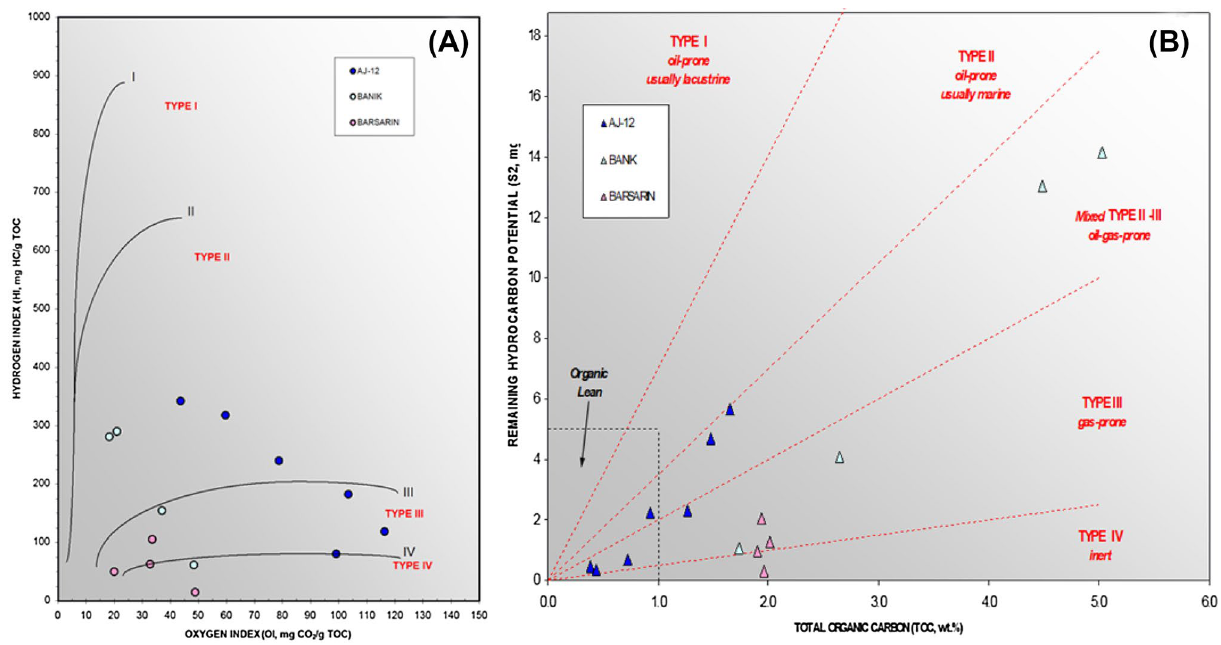
Fig. 12 a Cross plot of HI vs. OI of Chia Gara Formation, b Plot of Total Organic Carbon (TOC %) vs. S2 for source rock of the Chia Gara Formation. Samples from well Aj-12 and Banik sections are